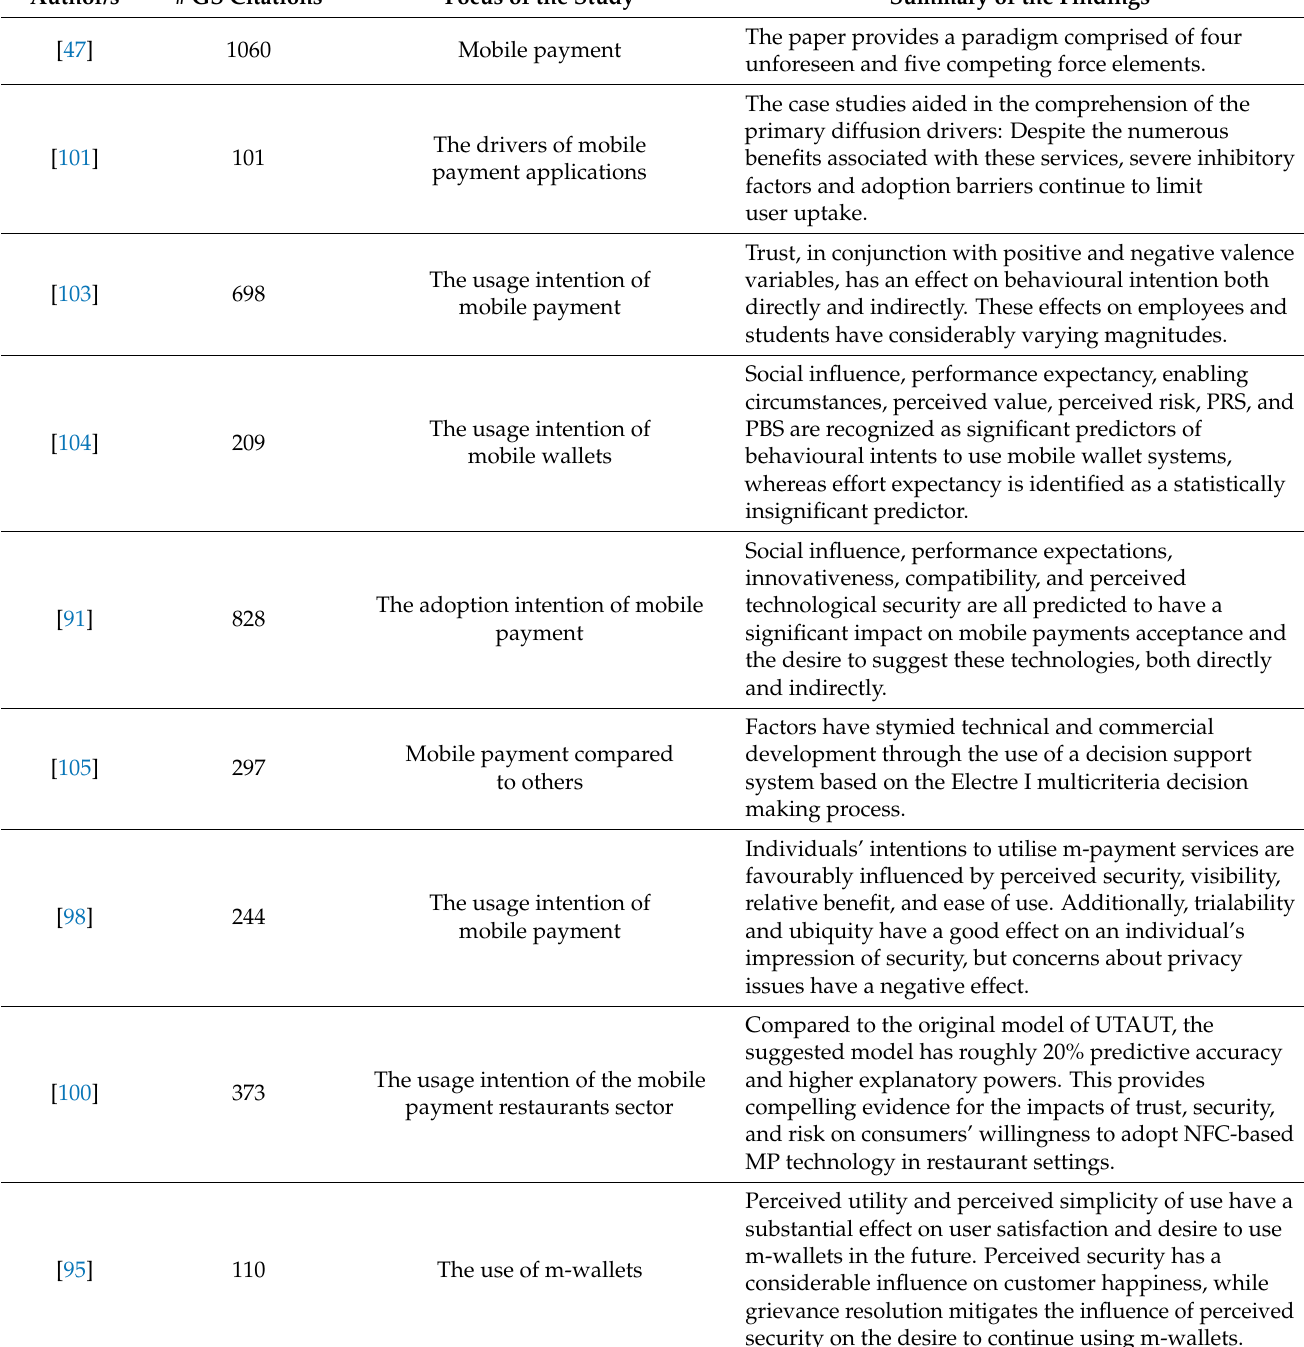
Table 7. Summary of studies in cluster